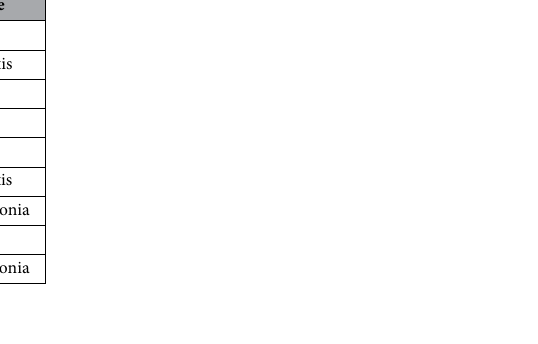
( Properties of a table ) Assuming a table dataset T, which contains t records (t is 9 in Table 1 below), each record corresponds to an entity, we mainly divide the attributes in the entity into three categories: